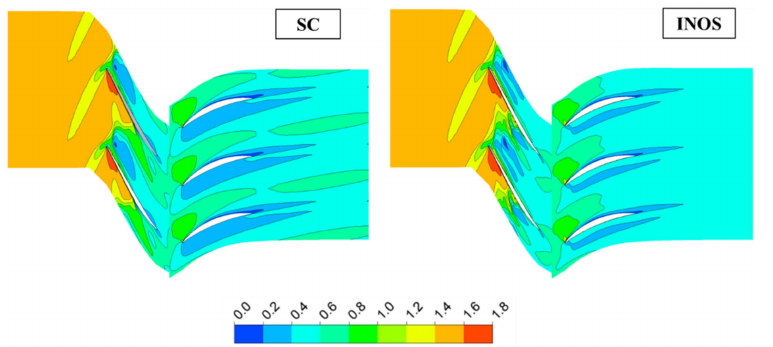
Figure 6. Relative Mach number contours at 98% blade span at near-stall condition (the left figure is reprinted from ref. [37]. Copyright 2021 Elsevier, Amsterdam, The Netherlands).